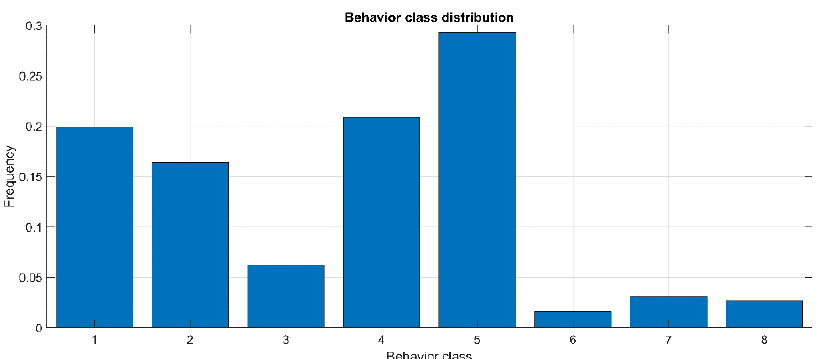
Figure 11. Results of the class frequency distribution from the observed dairy cows. Numbers on the x -axis refer to the behavior classes: 1 = standing; 2 = lying; 3 = standing and ruminating; 4 = lying and ruminating; 5 = eating; 6 = drinking; 7 = walking; 8 = other.